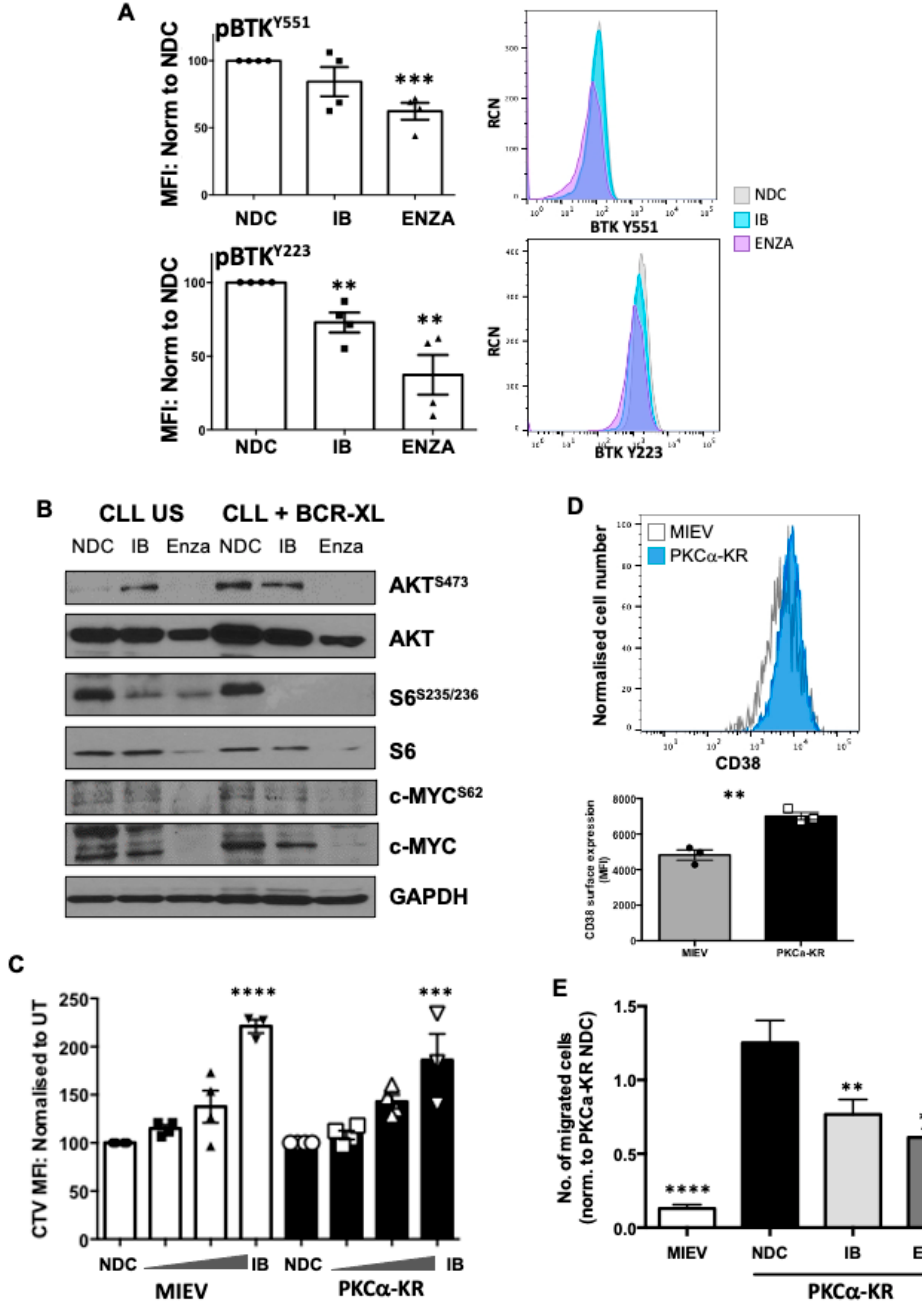
Figure 6. Inhibition of PKC β upon treatment with enzastaurin downregulates key proteins within the BCR signalosome in primary CLL cells. ( A , B ) Human CLL cells were treated with 1 µM IB or 10 µM Enza in the presence or absence of BCR crosslinking (BCR-XL; F(ab’) 2 fragment stimulation). A. Phospho-flow was used to analyse the levels of BTK Y551 and BTK Y223 phosphorylation upon treatment with drugs ± BCR-XL. Left-Graphs show the average MFI of the individual phospho-BTK sites as indicated, normalised to MIEV NDC ( n = 4 individual patient samples; NDC (circles), IB (squares), ENZA (triangles)). Right-Histogram plots show the effect of drug treatments on BTK Y551 and BTK Y223 phosphorylation as overlay (NDC—pale grey; IB—turquoise; ENZA—pink); ( B ) Western blots were performed to identify the effect of drug treatment on key proteins within the BCR signalosome in human CLL cells. Representative Western blots are shown. Densitometry of the Western blots for these proteins ( n ≥ 3 individual patients) is shown in Supplementary Figure S6; ( C ) Late co-culture MIEV and PKC α -KR cells (2 × 10 6 ) were labelled with CTV and cultured for 48 h in the presence (100 nM—3 µM) of increasing concentrations of IB (squares, triangles, inverted